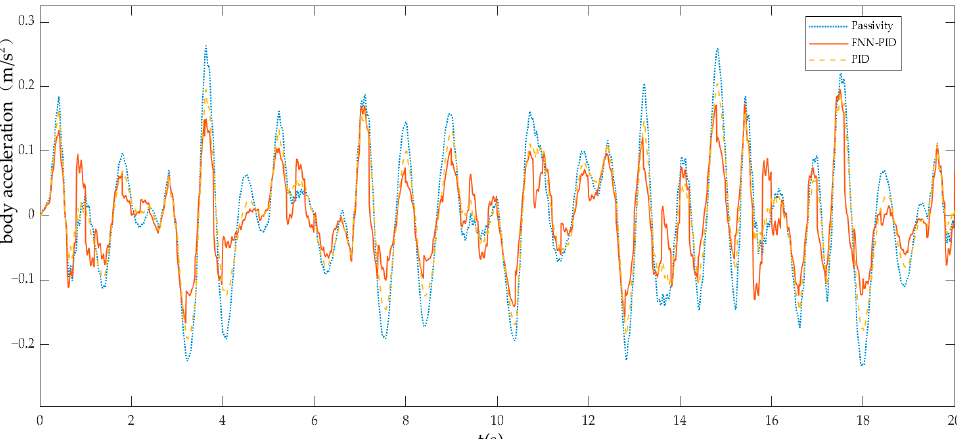
Figure 9. Comparison of Sprung Mass Acceleration simulation results.